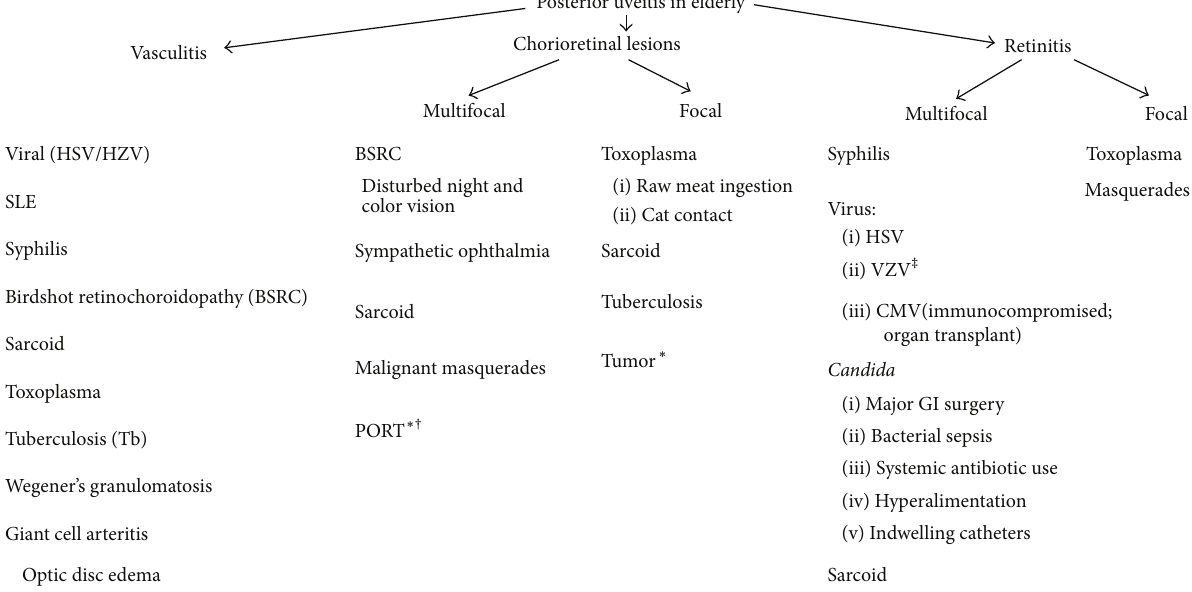
Figure 3: Differential diagnosis of posterior uveitis in elderly patients. usually occur ∗ without vitritis. † Elderly and immunocompromised elderly may manifest atypical lesions (large, multiple, and bilateral). ‡ Immunocompromised elderly may get progressive outer retinal necrosis (PORN). PORT: punctate outer retinal toxoplasmosis. CMV: